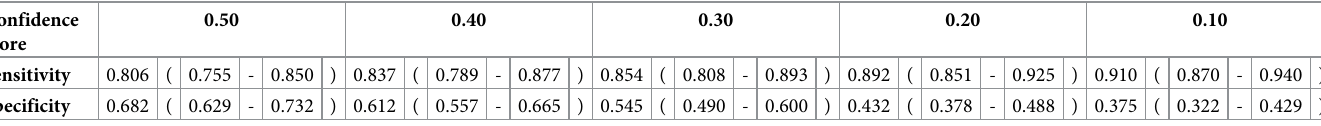
Table 2. Moving cut-off confidence score and test